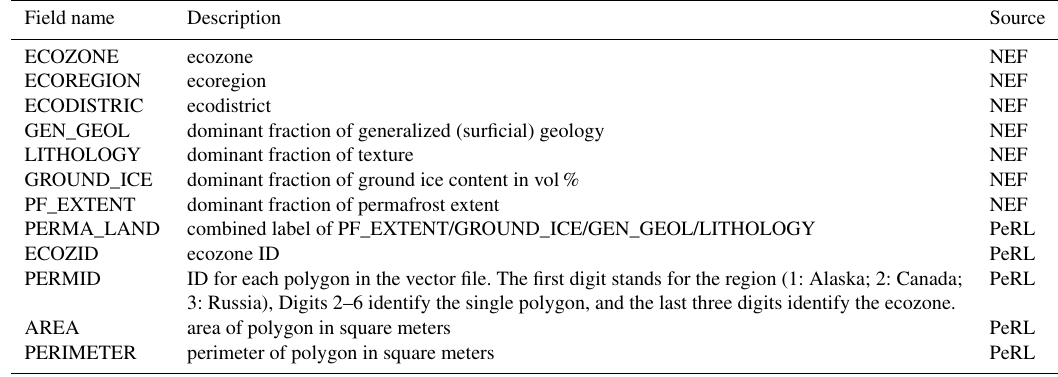
Table B2. Description of attributes contained in the polygon attribute table of Canadian permafrost landscapes (canada_perma_land.shp).